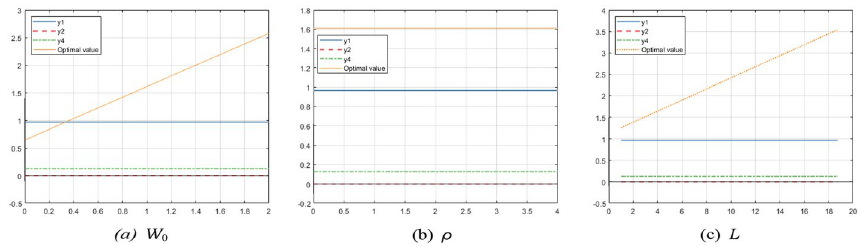
Fig. 4 Shadow Price of W 0 , ρ , and L . Panel ( a ) shows how the objective function and three dual variables change when the capital W 0 varies from 0 to 2 at the beginning of the current period. The x-axis is the variation range of input factors, and the y-axis is the value of objective function value and the marginal contribution of y 1 , y 2 , and y 3 . In the same way, Panel ( b ) and Panel ( c ) show the results of ρ and L respectively. When a parameter is changed, the initial value of other parameters is W 0